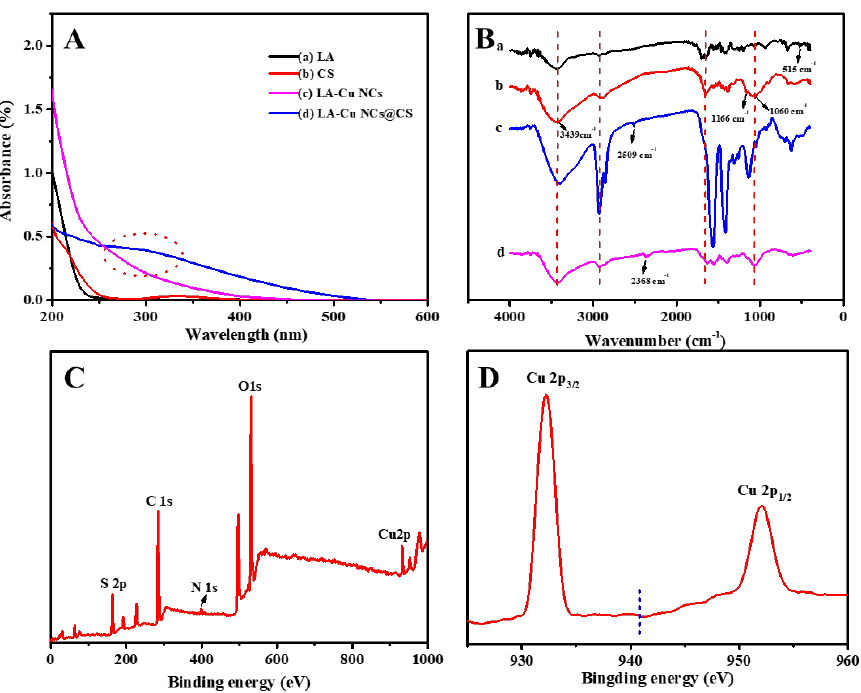
Figure 2. ( A )The UV − vis and ( B ) FT − IR spectra of LA (a), CS (b) LA − Cu NCs (c) and LA − Cu NCs@CS (d), XPS spectra of ( C ) LA − Cu NCs@CS and ( D ) Cu 2p region.